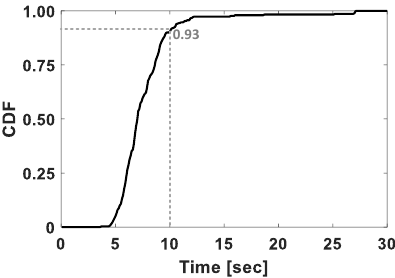
Figure 2. Cumulative Distribution Function (CDF) of time elapsed from the point of standing beside a vehicle to the point of being seated in the vehicle.